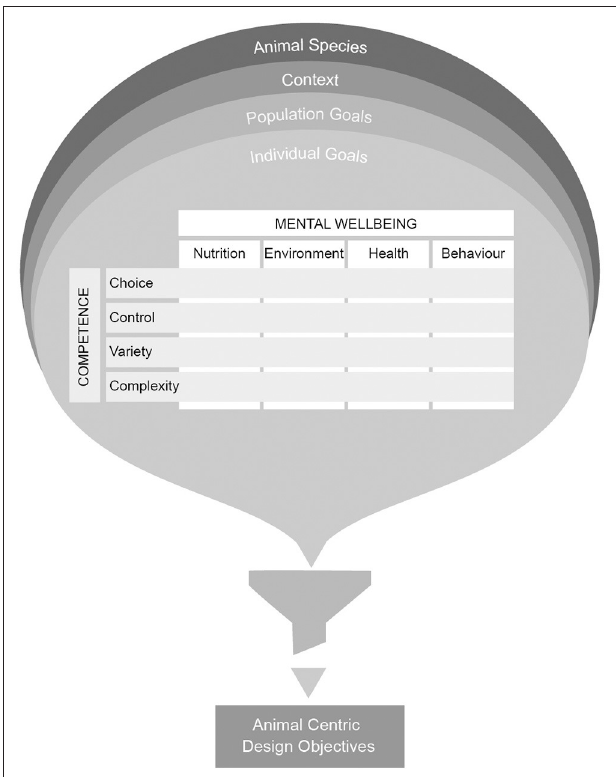
FIGURE 2 | The welfare through competence animal objectives canvas.